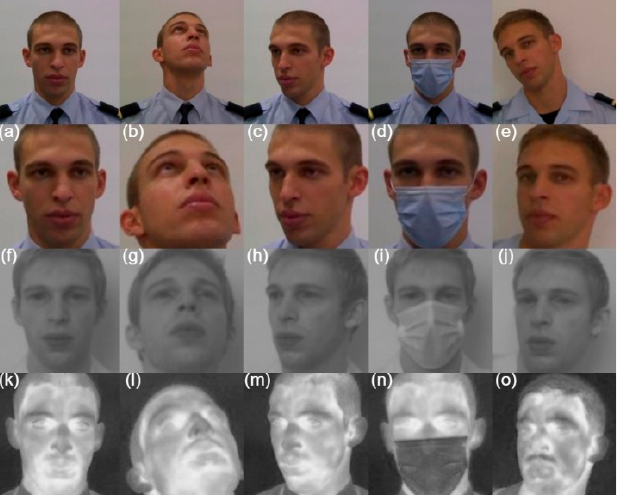
Figure 9. Results achieved by the proposed facial detection and alignment module in the different spectral bands. The images on the top are the originals in the VIS, before processing. Remain images correspond to facial alignment and detection in the spectral bands of VIS ( a – e ), NIR ( f – j ) and LWIR ( k – o ).